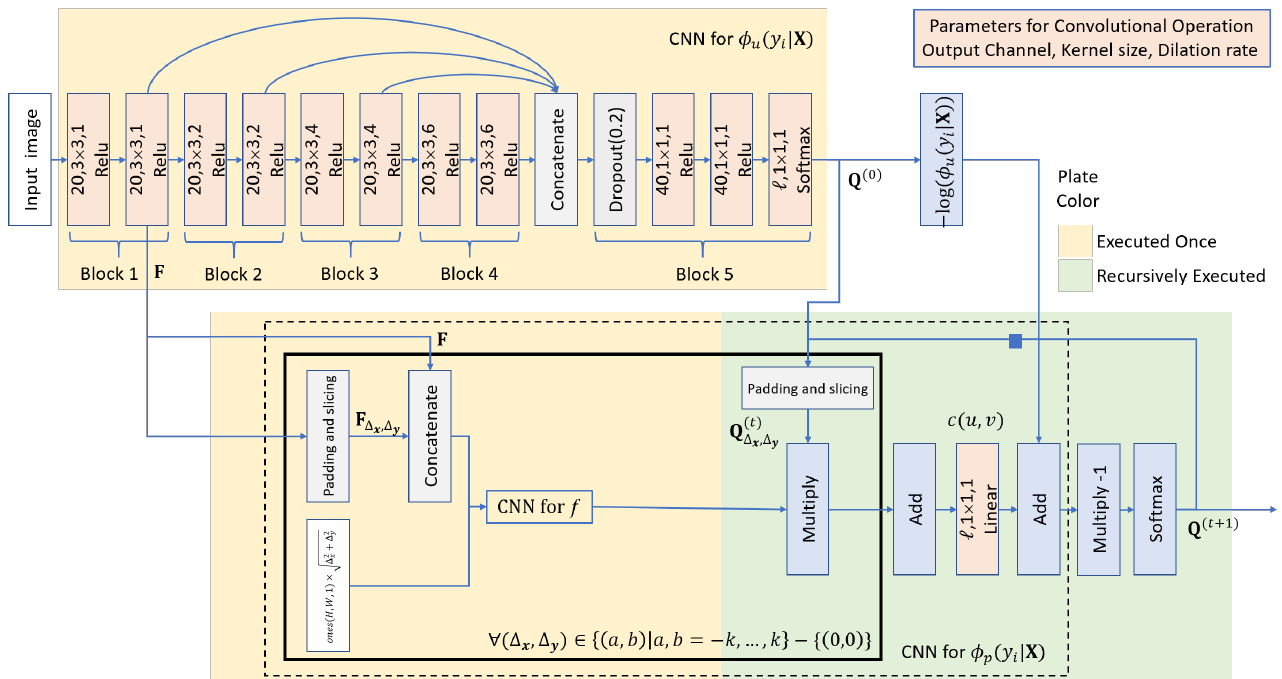
Figure 4. The neural architecture of Q ( y i | X ) , where F ∆ covers starting from the k + ∆ y th row and the k + ∆ x th column of F with k padded zeros at the top, bottom, left, and right side; in addition, “ ∀ ( ∆ x , ∆ y ) ” at the corner of the rectangle with solid lines indicates that the network inside is performed for each ( ∆ x , ∆ y )